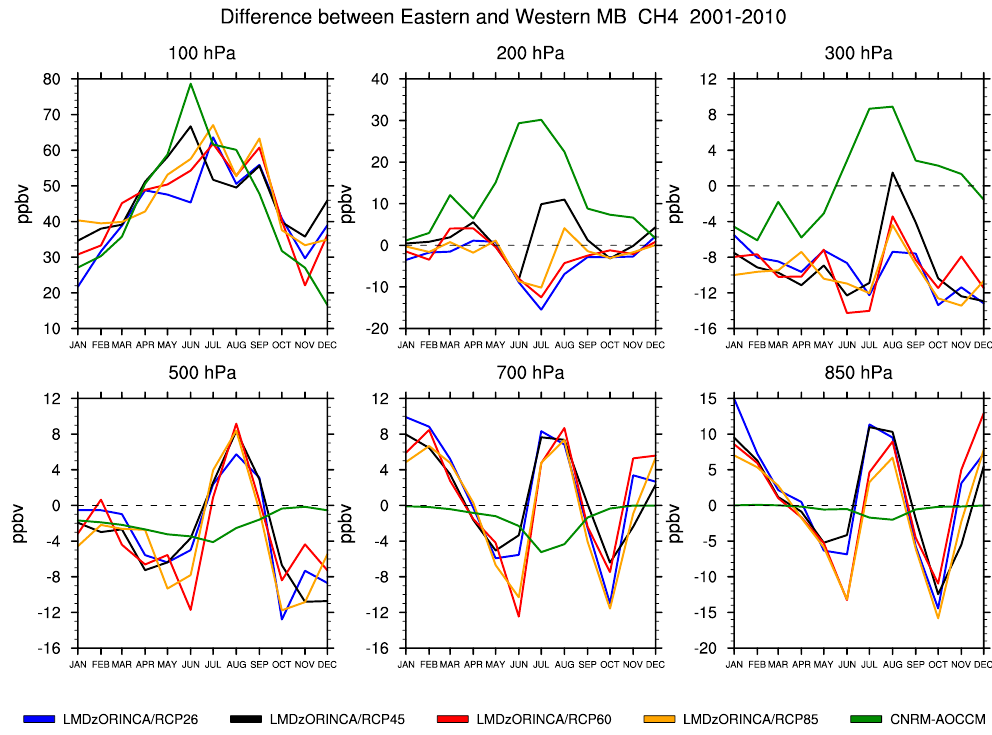
Figure 9. From top to bottom and from left to right: seasonal evolution of the difference in the CH 4 fields between the EMB and WMB over the climatological period 2001–2010 at 100, 200, 300, 500, 700 and 850hPa as calculated by CNRM-AOCCM (green) model and LMDz-OR-INCA according to the four IPCC scenarios: RPCs 2.6 (blue), 4.5 (black), 6.0 (red) and 8.5 (yellow). See Sect. 2.2 for more